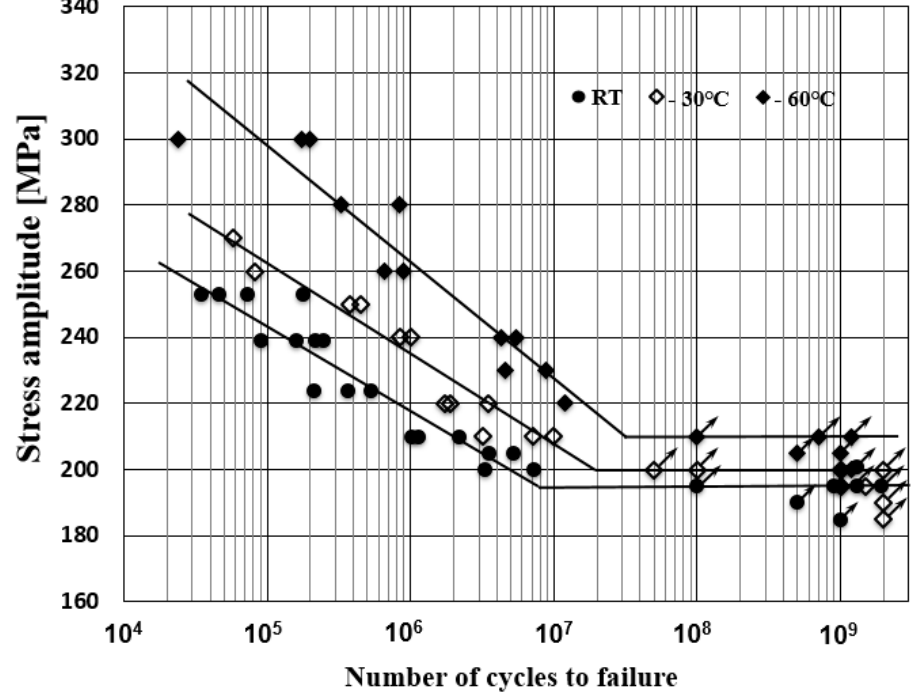
Figure 9. S–N diagram at room temperature (RT, 20°C), − 30 °C, and –60 °C.